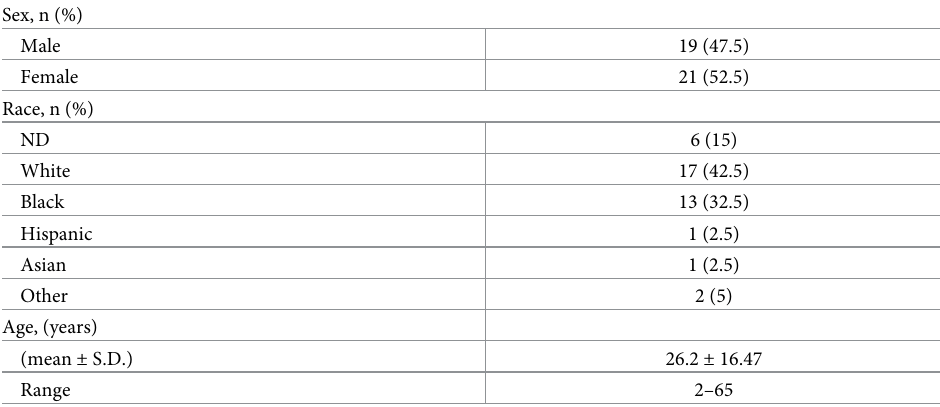
Table 1. Donor demographics for the tonsil specimens used in the study (n = 40).